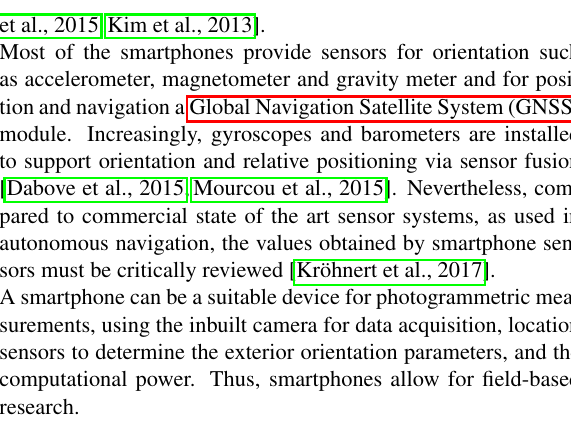
Figure 1. Weißeritz, Dresden. Floods 2002 (left), 2013 (right) 2 . et al., 2015,Kim et al.,